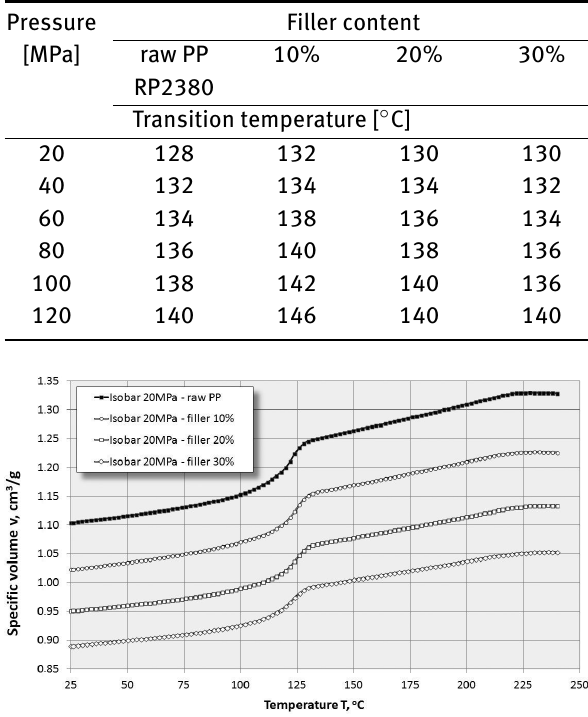
Table 2: Transition temperature versus filler content and pressure Pressure